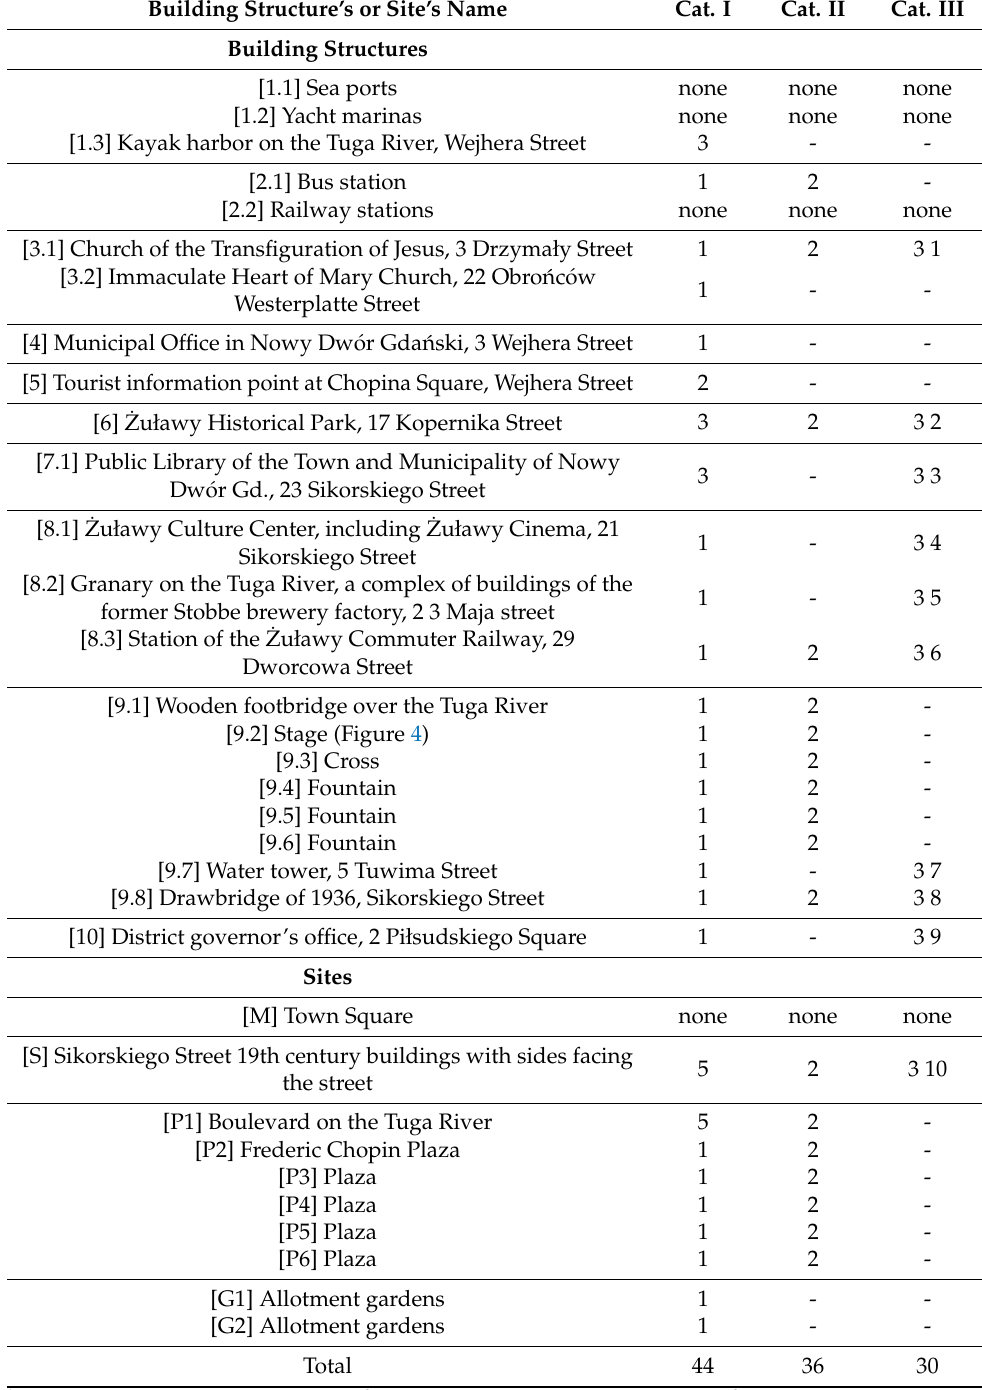
Table 7. The list of iconic building structures and sites with their assigned scores in Nowy Dw ó r